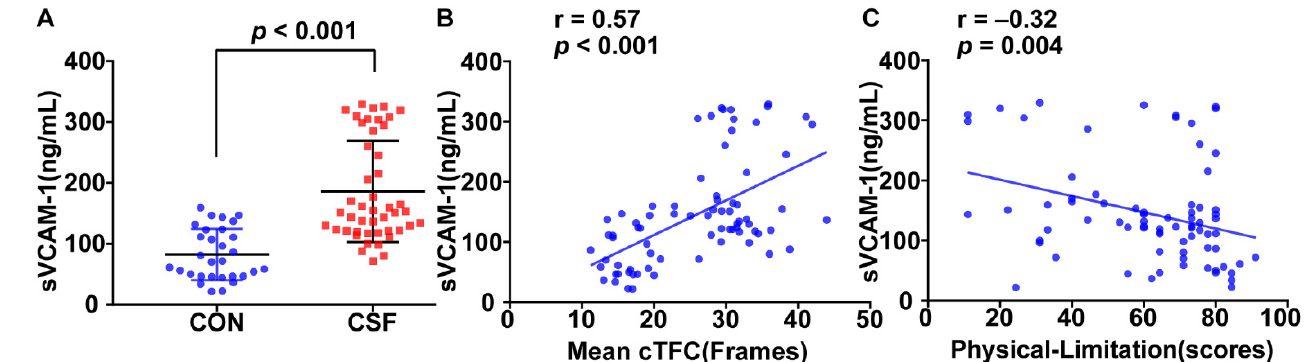
Figure 1. Relationship between sVCAM-1 level and coronary slow flow (CSF). Plasma sVCAM-1 level is significantly higher for patients with CSF than that for the control ( A ) and is positively correlated with mean corrected thrombolysis in myocardial infarction frame count (cTFC) ( B ). Plasma sVCAM-1 level is negatively correlated with SAQ physical limitation score ( C ).